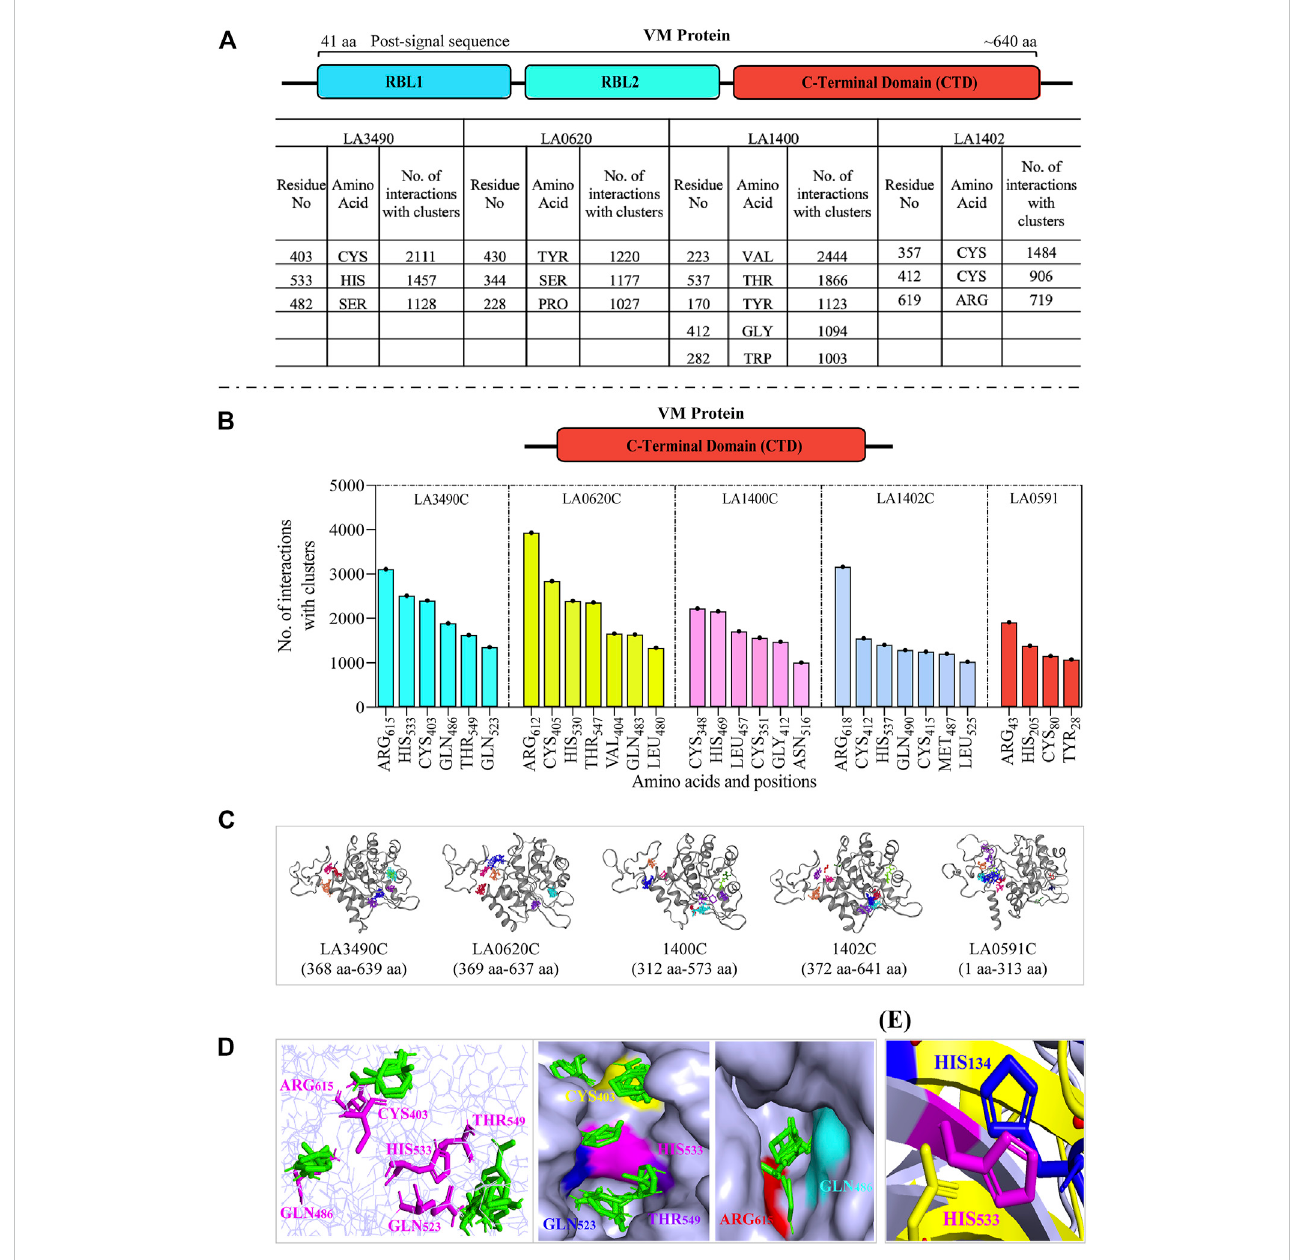
FIGURE 5 Comparative assessment of FTMap-based hot-spot and ligand binding residues in full-length and C-terminal domain (CTD) of VM proteins. (A) The FTMap machine learning-based algorithm using AlphaFold generated full-length VM proteins (LA3490, LA0620, LA1400 and LA1402: shown by schematic diagram) structure shows less hot-spots residues because of low binding energy and having a smaller number of interactions with clusters. Below the horizontal dash line (B − D) showing the analysis of carboxy-terminal domain (CTD). The schematic diagram shown the CTD domain. (B) Histogram showing the CTD of VM proteins (LA3490, LA0620, LA1400, LA1402, and LA0591) having higher number of hot-spots residues with high binding energy and showing a high number of interactions with clusters. (C) Three-dimensional view of CTD of VM proteins showing ligand binding sites. (D) The magenta colors are the hot-spot residues (Arg615, His533, Cys403, Gln486, Thr549, and Gln523, with respect to CTD of LA3490) shows binding with ligands (green color) in the three-dimensional view in left panel. Surface view of CTD of LA3490 shows binding of ligands with hot-spot residues in deep pockets in right panels. (E) Structural superimposition of CTD of LA3490 and bovine DNase (3DNI) shows the overlap of His533 (LA3490) with the catalytic residue His134 of bovine